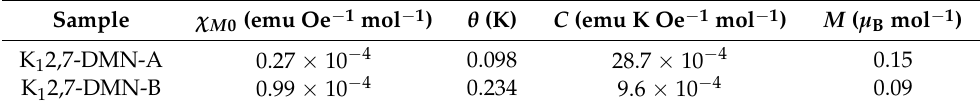
Table 1. Curie–Weiss fitting parameters of K 1 2,7-DMN-A and K 1 2,7-DMN-B